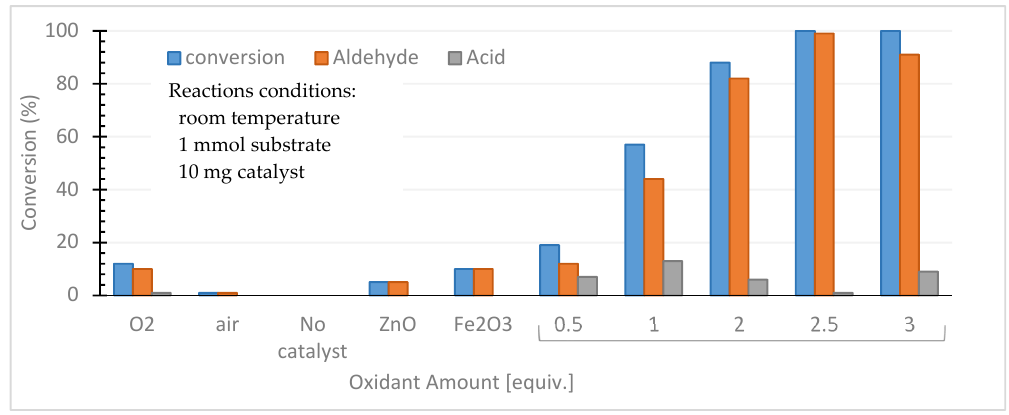
Figure 7. Reactivity of ZnFe 2 O 4 -NP in the presence of the different oxidant (H 2 O 2 ) amounts and compared to blank experiments (ZnO and Fe 2 O 3 ) and no oxidant.